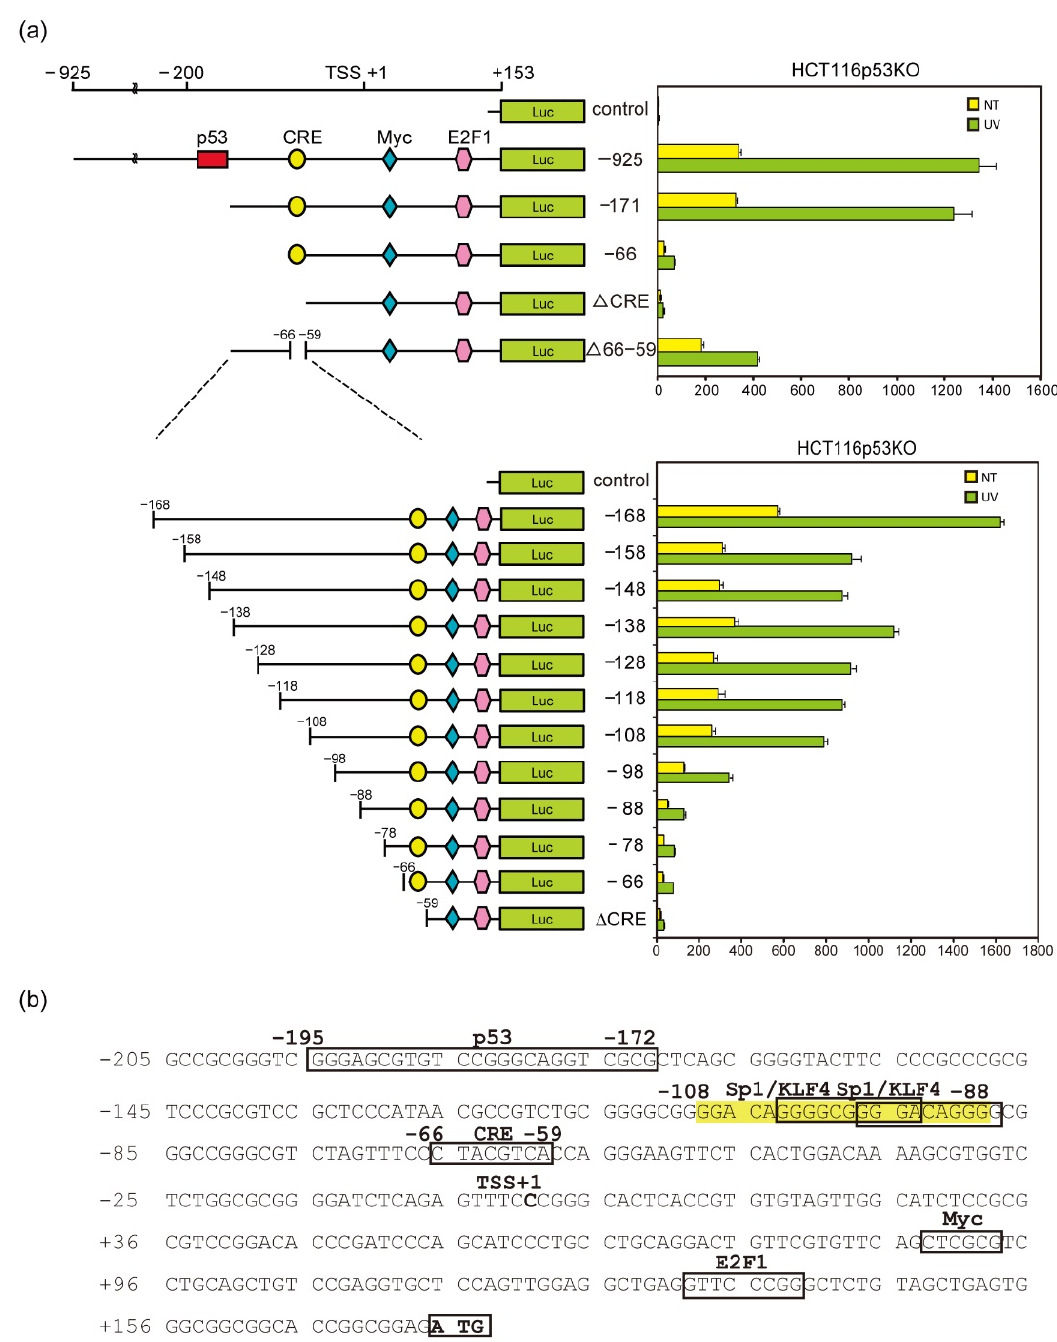
Figure 3. Identification of transcription factor binding sites in the NOXA promoter. ( a ) After 24 h of transfection of reporter constructs, cells were irradiated with UV light (green bars) or not subjected to irradiation (yellow bars) for 24 h, after which Firefly- and Renilla-dependent luciferase activities were determined. Firefly-dependent luciferase activity was normalized by the Renilla signals. Data are shown as the mean ± S.D. ( n = 3). Each value represents the average of three independent experiments. ( b ) TFSEARCH analysis prediction of the transcription factor binding sites in the NOXA promoter region ( −